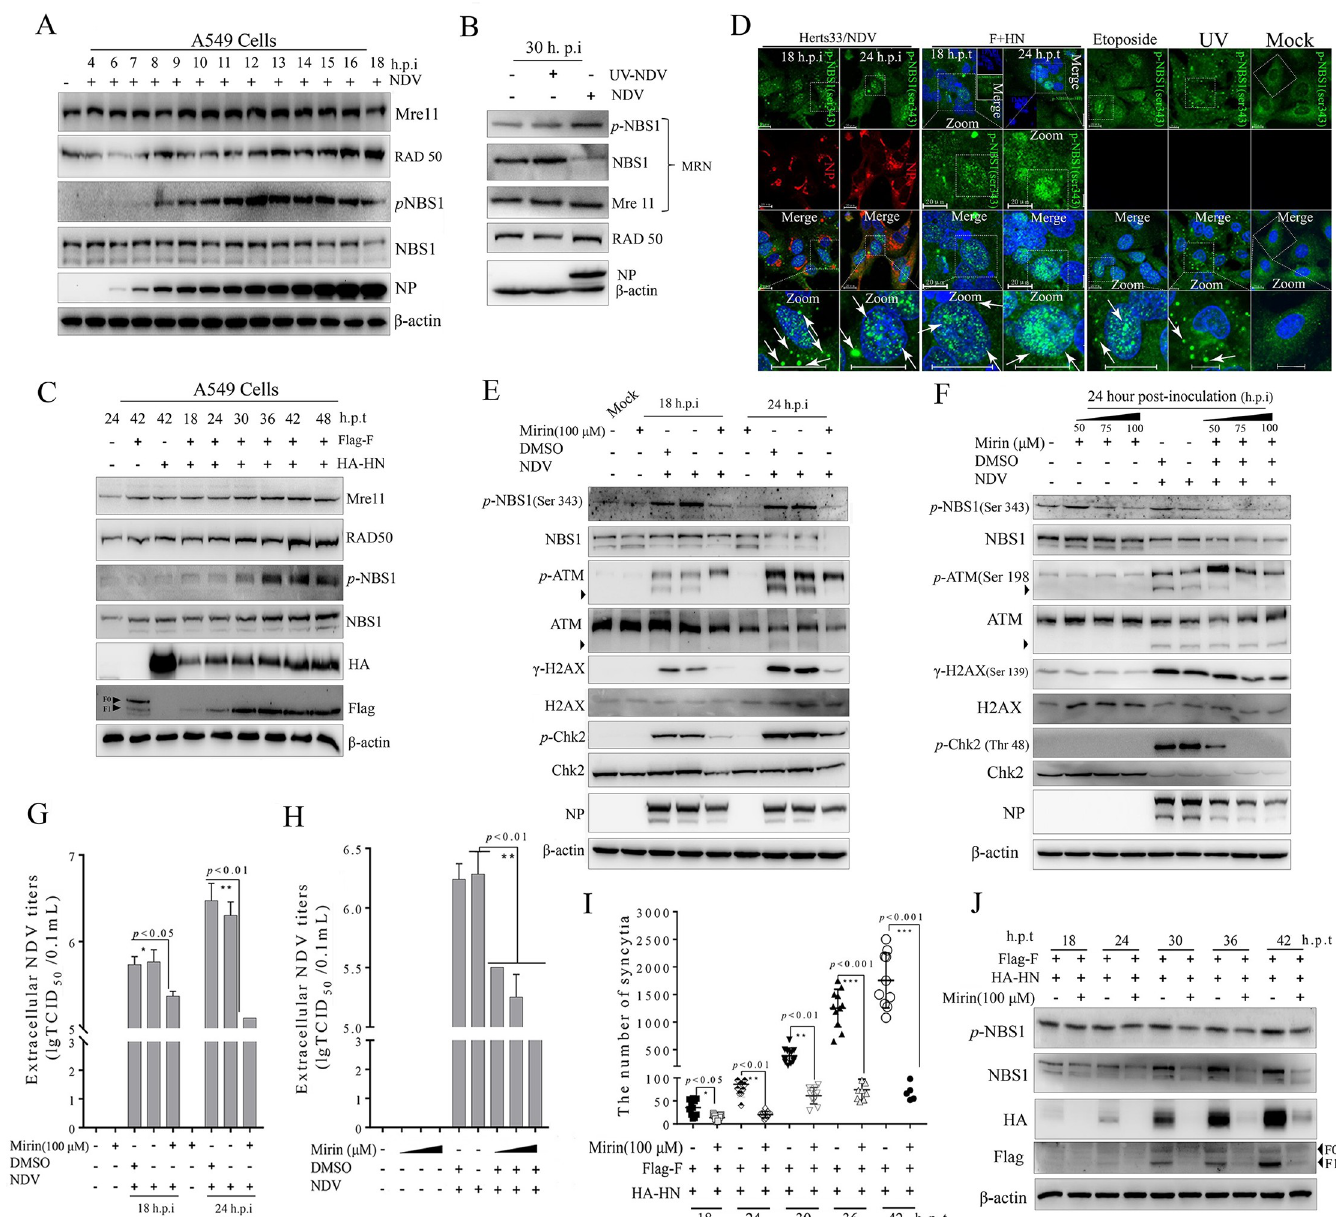
Fig 7. Virulent NDV infection and F-HN co-expression activated the Mre11-Rad50-NBS1 (MRN) complex sensor in A549 cells. (A) Virulent oncolytic NDV infection activated the MRN sensor of ATM-dependent DSB signaling in A549 cells. Western blot samples were prepared from A549 cells after virulent oncolytic NDV infection (Herts 33/NDV strain) (MOI = 1) corresponding to the marked timepoints, and analyzed in accordance with the procedures in the Materials and Methods section. β -actin served as a loading control. (B) NDV replication was essential for the activation of MRN sensor. A549 cells were inoculated with virulent oncolytic NDV (Herts33/ NDV) (MOI = 1) and UV-inactivated NDV. At 30 h.p.i., Western blot samples were collected and analyzed in accordance with the procedures in the Materials and Methods section. (C) F with HN cooperated synergistically to activate the MRN sensor of ATM-mediated DSB signaling in A549 cells. A549 cells were transfected with the plasmids Flag-F, HA-HN, or both. Western blot samples corresponding to the marked timepoints were collected and analyzed in accordance with the procedures in the Materials and Methods section. (D) Representative images showing that virulent oncolytic NDV infection and F-HN co-expression triggered nuclear aggregation of phosphorylated NBS1 on Ser343 in A549 cells. A549 cells were mock-infected, or NDV-infected (MOI = 1) for 18 and 24 h, UV-exposed for 30 min, and treated with etoposide at a final concentration of 80 μ m for 24 h. The UV and etoposide treatment groups served as the positive controls. A549 cells were co-transfected with both Flag-F and HA-HN plasmids at the indicated timepoints. At 18 and 24 h.p.t., coverslips were examined by IFA. p -NBS1 (green); nuclei (blue); NDV (red). Scale bars = 20 μ m. (E) MRN complex activity was required for intracellular NDV replication in a time-dependent manner. A549 cells were pretreated with a working concentration of Mirin at 100 μ m for 1 h prior to NDV infection. A549 cell were mock-infected and NDV-infected (MOI = 5) for 18 and 24 h. At 18 and 24 h.p.i., Western blot samples were prepared and analyzed in accordance with the procedures in the Materials and Methods section. The monomer ATM was marked with a